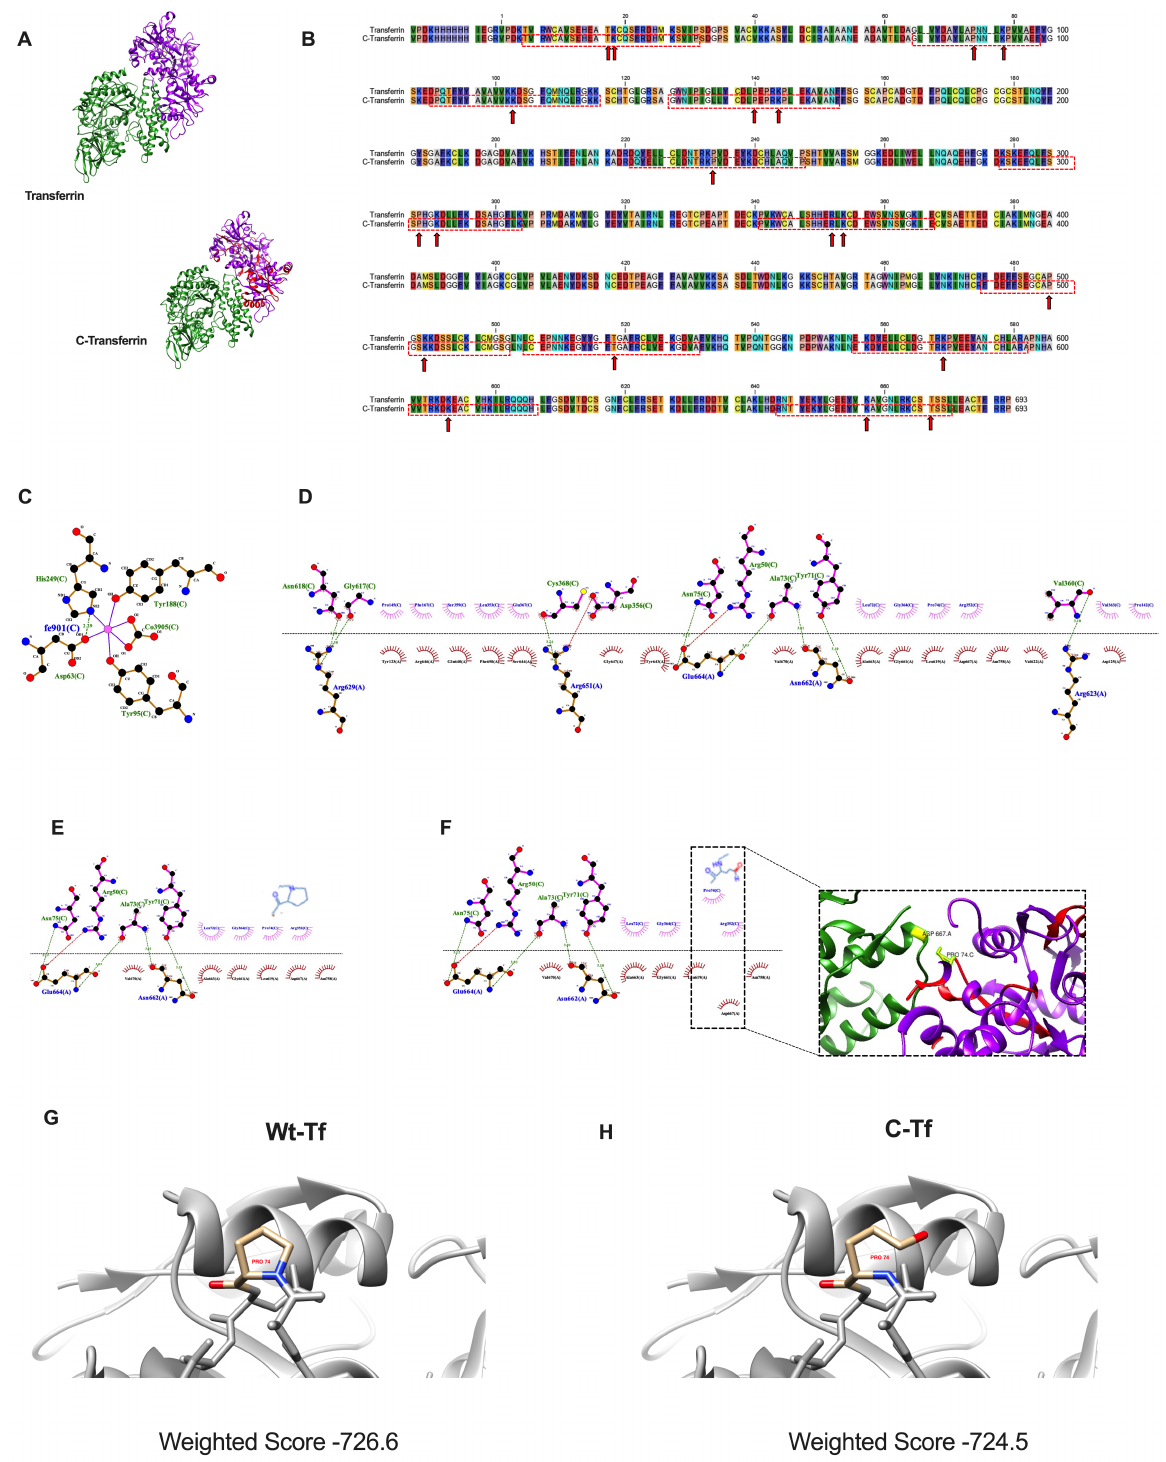
Figure 5. The effect of transferrin carbonylation on transferrin receptor interaction. ( A ) Tridimensional structure of transferrin (Protein Data Bank) and carbonylated transferrin (C-transferrin) showing the localization of possible carbonylation residues (in red). ( B ) Alignment of nucleotide sequence of transferrin-transferrin receptor interaction. Red boxes represent predicted carbonylated residues based on bibliography and user-friendly webserver for iCar-PseCp ( C ) 2D representation using Ligplot+ of interactions for the transferrin and iron and ( D ) transferrin and transferrin receptor. A representative chain of each protein is shown (Chain C, for TfR and chain A, for Tf). The side